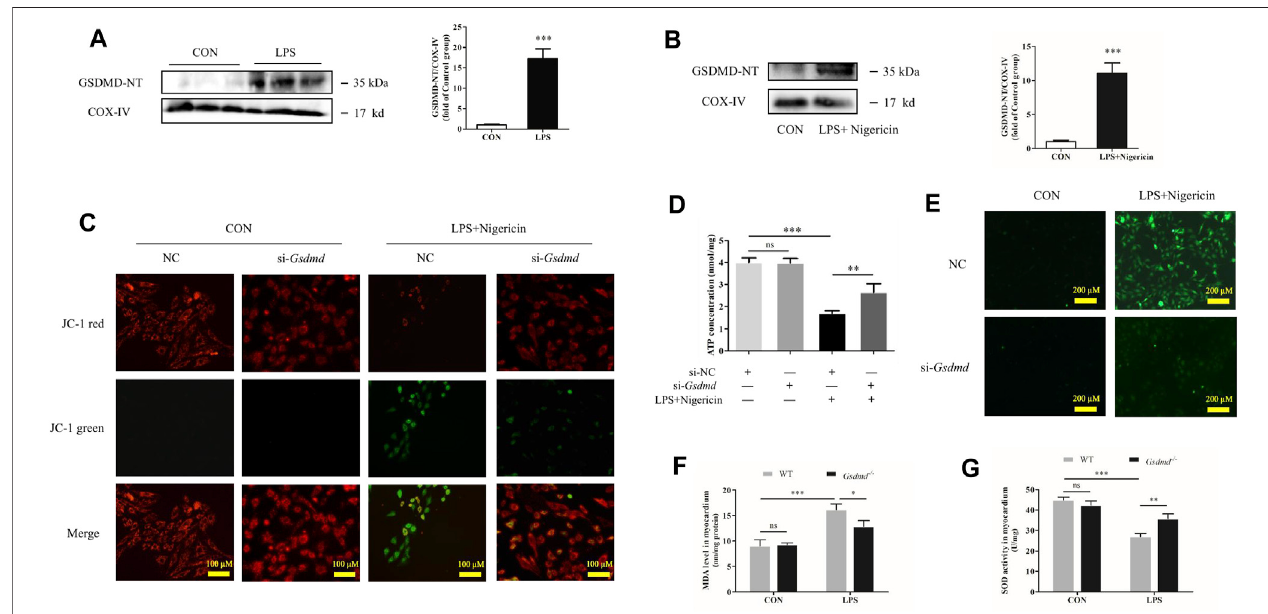
FIGURE 6 | GSDMD enrichment in mitochondria leads to mitochondrial dysfunction, ROS generation, and NLRP3 in fl ammasome activation. (A) Expressions of GSDMD-NT protein in mitochondria of heart tissue were measured by Western blotting analysis. The results were normalized to the expression of COX-IV (n (cid:1) 6). (B) Expressions ofGSDMD-NT protein in mitochondria ofH9c2 cellsweremeasured by Western blottinganalysis.The results were normalized tothe expression ofCOX-IV (n (cid:1) 3). (C) Mitochondrial membrane potential was assessed by JC assays in each group. (D) ATP level in each group (n (cid:1) 3). (E) ROS level in H9c2 cells. (F) MDA levels in heart tissue from each group. (G) SOD activity in heart tissue from each group. The data are expressed as the mean ± SD. * p < 0.05, ** p < 0.01, *** p < 0.001.